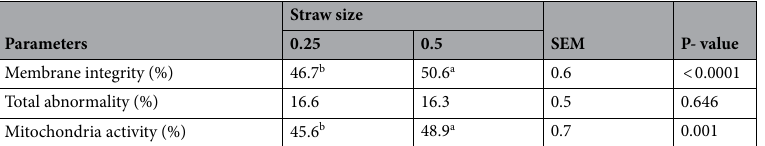
Table 4. Effect of straw size on plasma membrane integrity, total abnormalities and mitochondria activity thawed rooster sperm. Different letters within the same row show significant differences among the groups (P < 0.05).